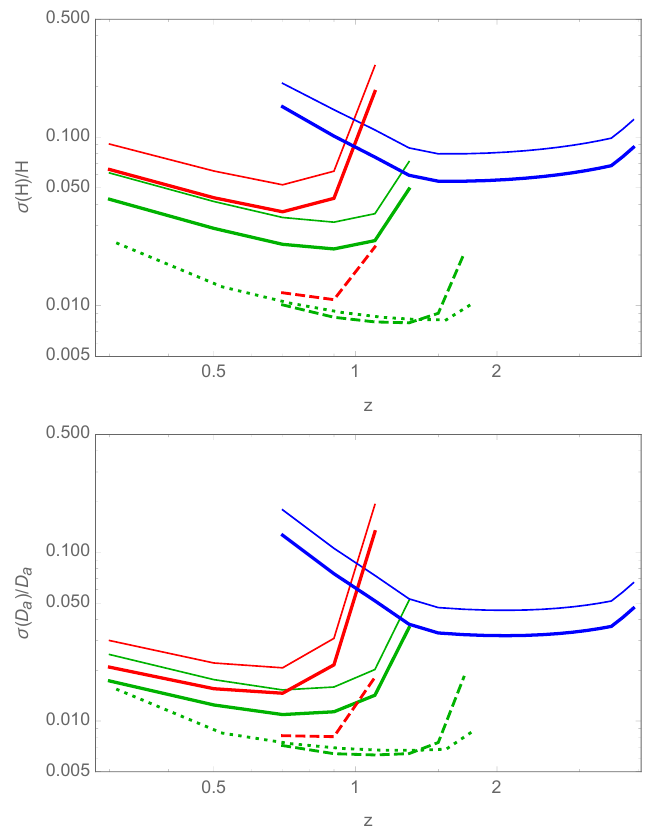
Figure 10. Forecasted constraints on radial ( H ) and angular ( D a ) BAO relative error from the galaxy catalogs produced by J-PAS (thick solid lines for 8500deg 2 , thin solid lines for 4000deg 2 ) as compared with DESI (dashed lines, 14,000deg 2 ) and Euclid (dotted lines, 20,000deg 2 ). LRGs in red, ELGs in green and QSOs in blue. Redshift bins of ∆ z = 0.2 are used [26].